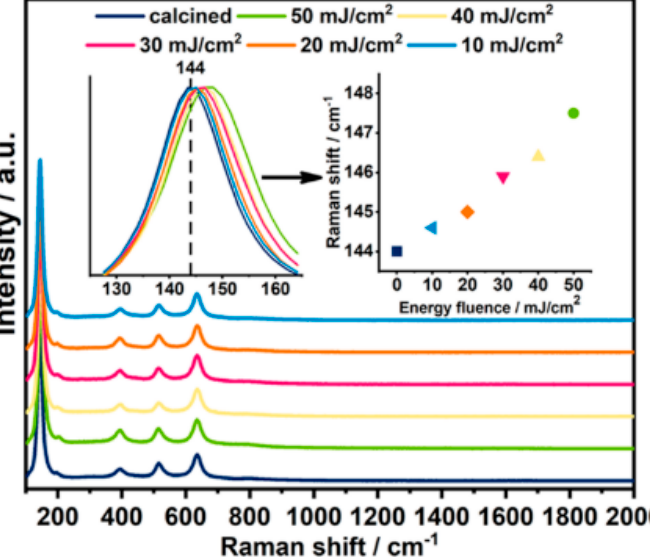
Figure 4. Raman spectra recorded for laser-treated TNTs in comparison to a calcined sample. Inset (a): dependence of the E g(1) position on the utilized laser energy fluences. Reprinted with permission from [53].